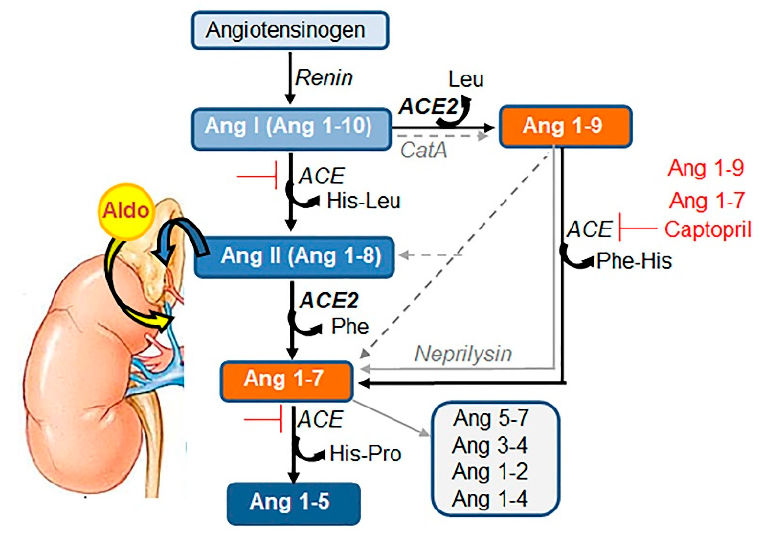
Figure 1. Components of the Renin-Angiotensin System (RAS). Bioactive peptides of angiotensinogen, Ang I or Ang (1–10), Ang II or Ang (1–8), and Ang (1–7) are depicted as rectangular shapes. The cleavage enzymes of renin, angiotensin-converting enzyme (ACE), ACE2, cathepsin A (CatA), and neprilysin are indicated in italics. The central panel shows the canonic RAS pathway. ACE cleaves dipeptide His-Leu, which converts decapeptide Ang I into octapeptide Ang II (blue rectangles). ACE2 cleaves a neutral amino acid, Phe, that converts Ang II into Ang 1–7 (orange rectangles). The alternative pathways by ACE and ACE2 (black arrows) as well as those mediated by other enzymes (gray lines) are shown on the right. Captopril is synthetic and Ang 1–7 and Ang 1–9 are natural inhibitors of ACE (red lines). Ang 1–7 inhibition presents a classical feedback mechanism for physiological control of Ang II levels in circulation. One example of the convergence of Ang II with other endocrine pathways for the regulation of blood pressure is shown on the left. Circulating Ang II initiates the production of aldosterone (Aldo) from cholesterol in the adrenal cortex.